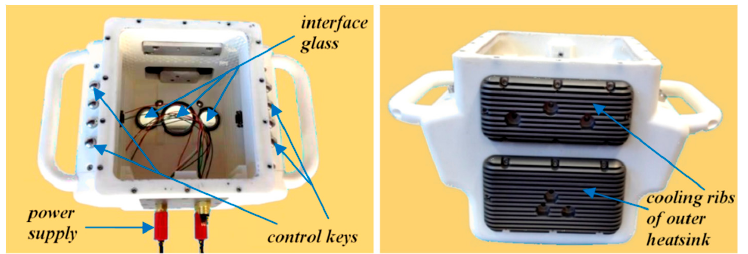
Figure 6. Two housing views showing certain sensor elements.